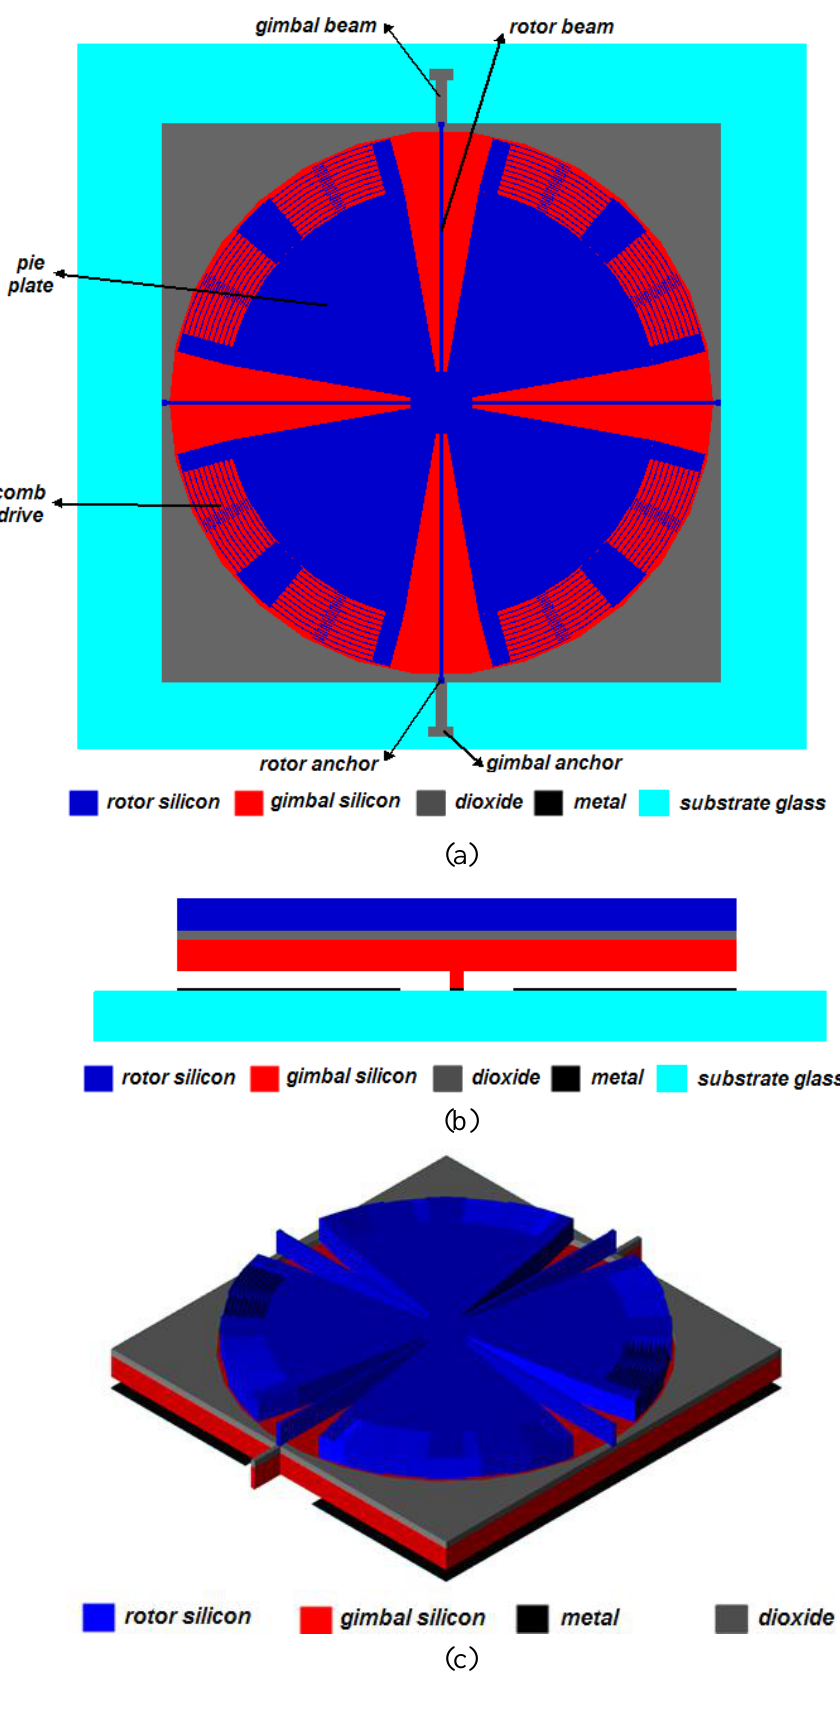
Figure 2. (a) Top view of MCMG. (b) Cross section of MCMG. (c) Solid model of MCMG. (The figures are not to